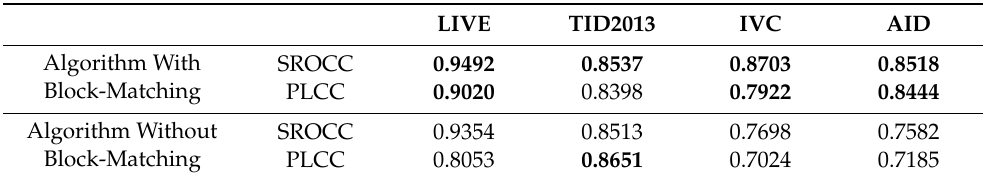
Table 3. Overall SROCC / Pearson linear correlation coe ffi cient (PLCC) values of BIQA algorithm with and without